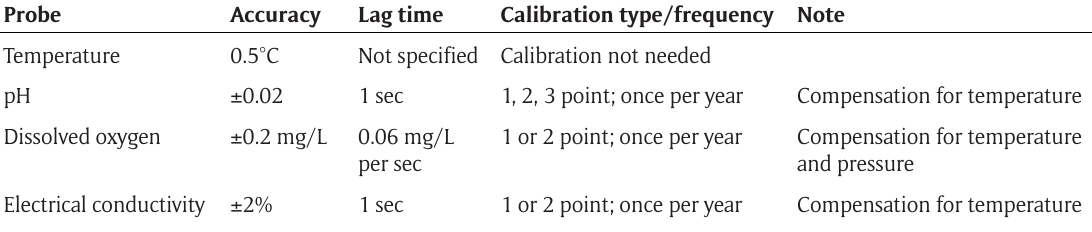
Table 1: Water array probes with vendor-supplied accuracy and sample information.